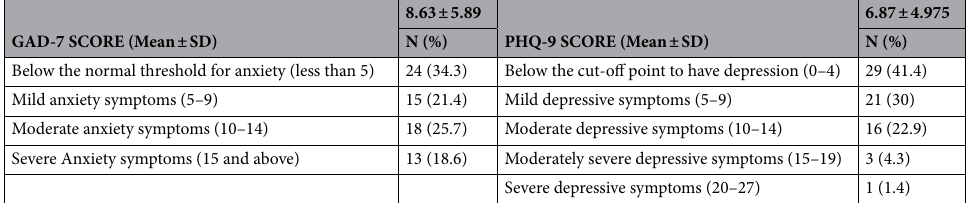
Table 2. Anxiety and depressive symptoms scores in 70 consecutive patients with UC. UC ulcerative colitis, GAD-7 generalized anxiety disorder-7, PHQ-9 patient health questionnaire-9, SD standard deviation.